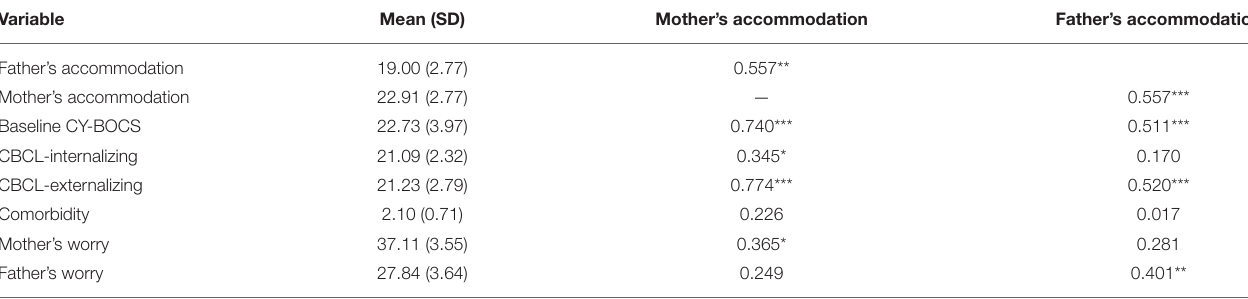
TABLE 2 | Pearson correlation coefficients between family accommodation and other variables.